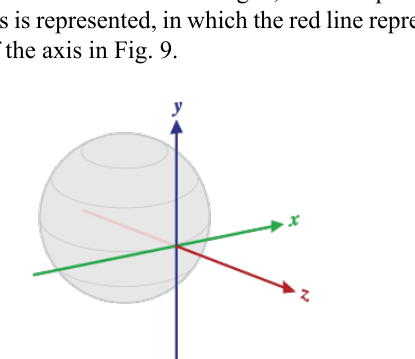
Figure 9. Smartphone sensor coordinate axes. Source: Android Developers (2021).